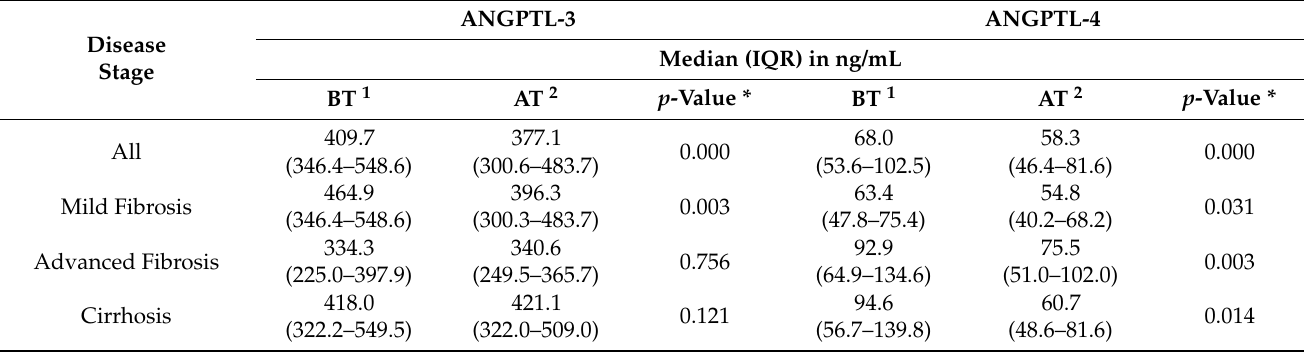
Table 4. ANGPTL-3 and ANGPTL-4 levels at various stages of HCV infection before and after DAA administration. Disease